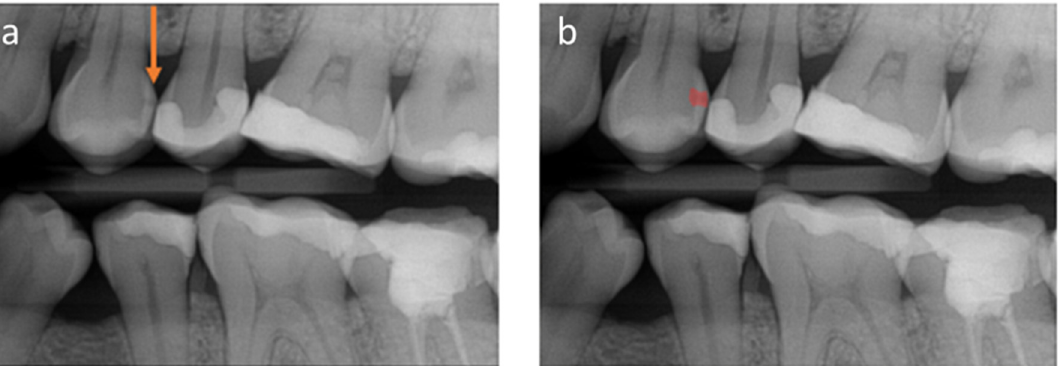
Figure 1. The radiographs shown in the vignette investigation. ( a ) Radiograph with a caries lesion; the orange arrow indicates the presence of the caries lesion (standard communication/control). ( b ) The same radiograph, with the caries lesion being indicated by an AI-generated pixel blob in red (AI-based communication). Table 1. Findings of the vignette-based controlled investigation. The mean (standard deviation) Likert-scale values (from 1—strongly disagree to 5—strongly agree) are shown. Bold values indicate statistically significant differences ( p < 0.05/Wilcoxon).